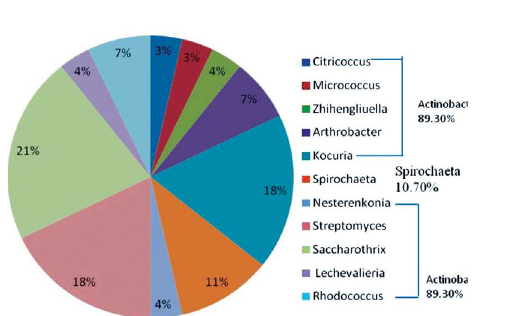
Fig. 2. Generic compositions of bacteria in Perna